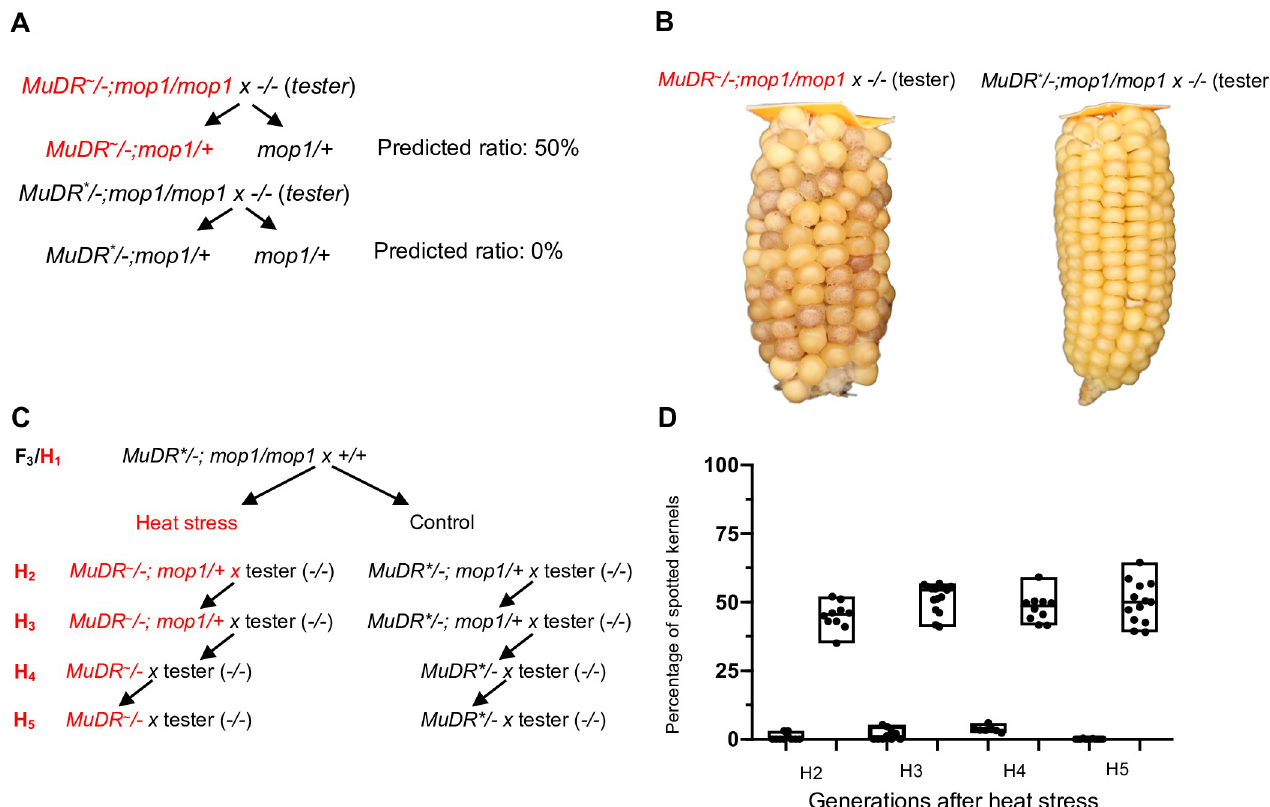
Fig 6. Testing transgenerational inheritance. (A) A schematic diagram showing the crosses used to determine transgenerational inheritance. (B) Ears derived from heat-treated and control individuals. (C) Crosses done in the generations following heat stress. (D) Ratios of spotted kernels in subsequent generations following the heat stress (H 1 ) generation. Red text indicates a sample that has been heat-reactivated.